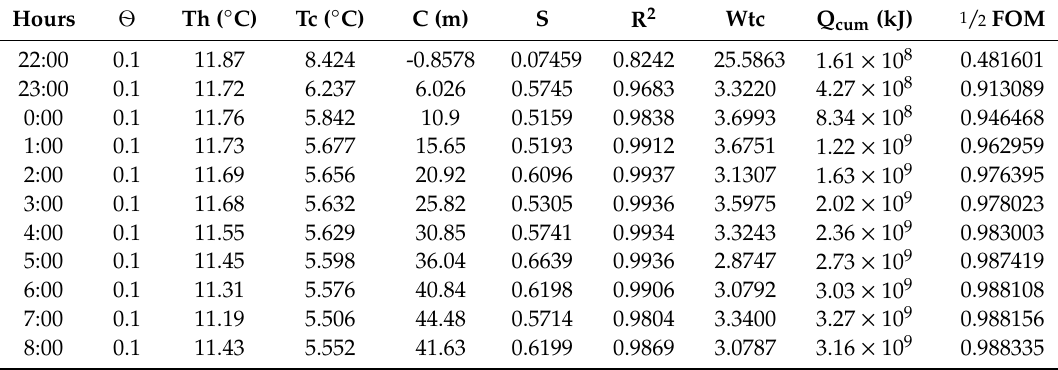
Table A9. 14th–15th October 2019 Curve Fitting and Performance Parameter